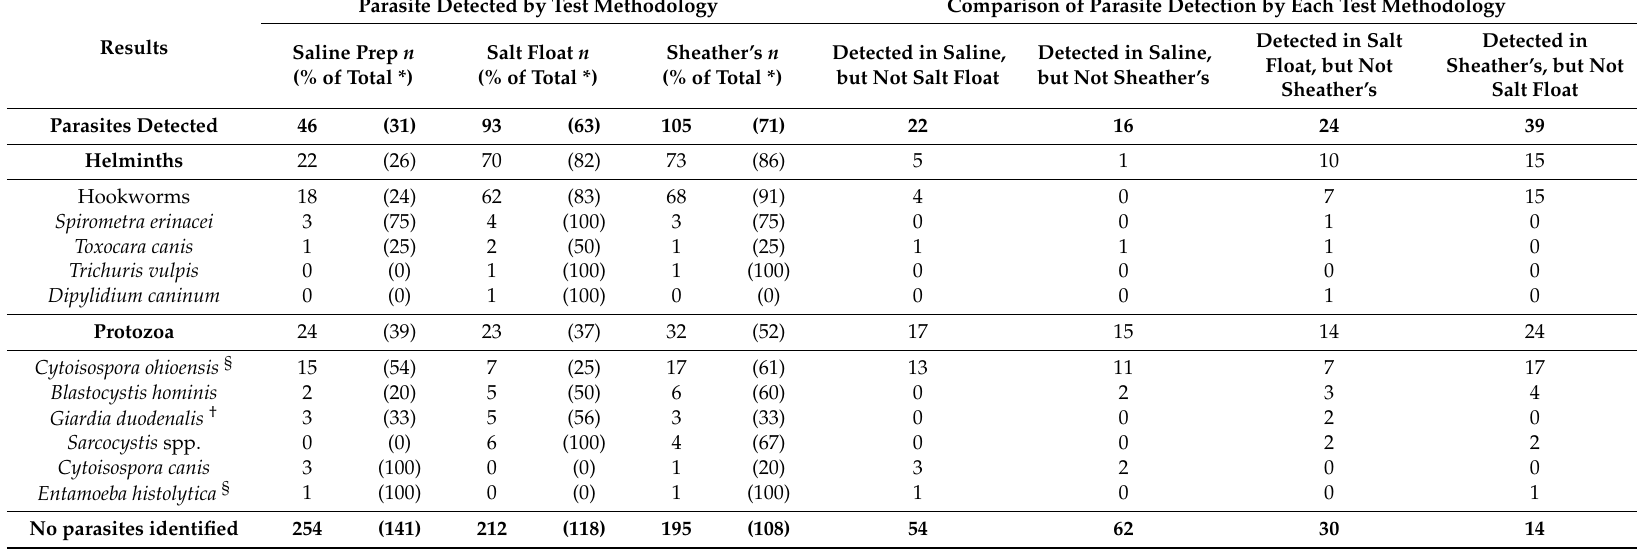
Table 2. Comparison of intestinal parasite detection by three test methodologies used in a survey of 300 domestic dog faecal samples collected in the greater Rockhampton region of Central Queensland between February and November